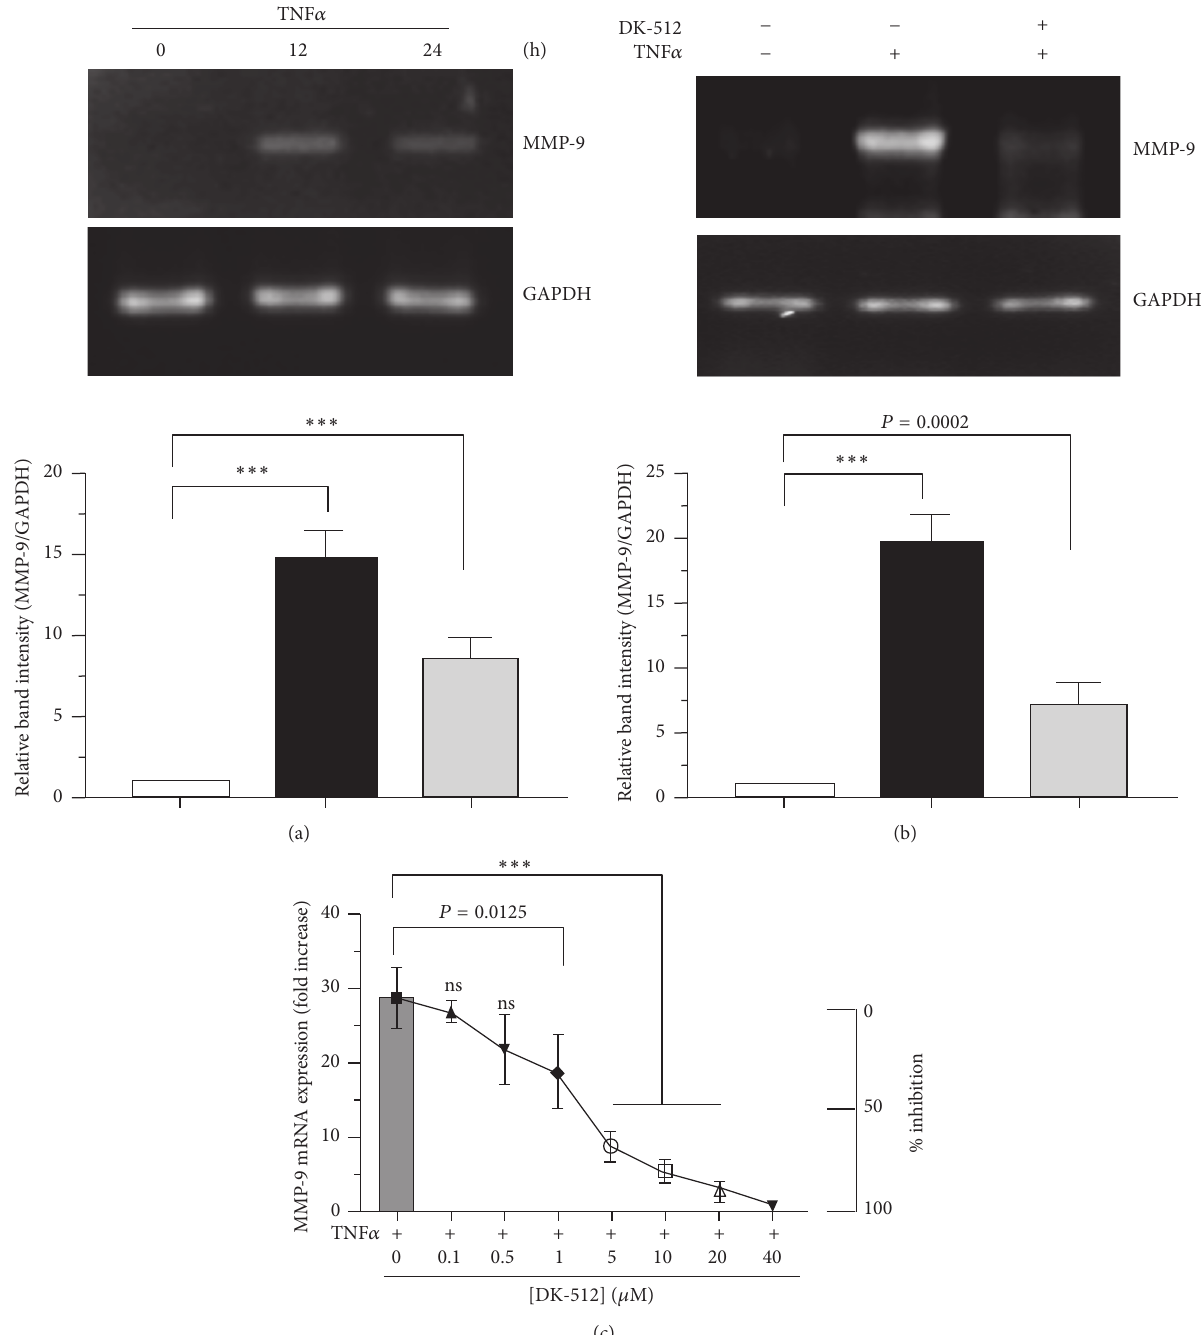
Figure 3: Effect of DK-512 on the inhibition of TNF 𝛼 -induced MMP-9 mRNA expression. (a) RT-PCR analysis. MDA-MB-231 cells were treated with 10ng/mL TNF 𝛼 for 12 and 18h. Total RNA was isolated and RT-PCR was performed. GAPDH mRNA was used as an internal control. Band intensities were measured using ImageJ software. The data shown represent the mean ± SD ( 𝑛 = 3 ). ∗∗∗ 𝑃 < 0.001 . P value was analyzed by Sidak’s test. (b) RT-PCR analysis. MDA-MB-231 cells were pretreated with 5 𝜇 M DK-512 for 30 min before the addition of 10ng/mL TNF 𝛼 . After 12h, total RNA was isolated and RT-PCR was performed. GAPDH mRNA was used as an internal control. Band intensities were measured using ImageJ software. The data shown represent the mean ± SD ( 𝑛 = 3 ). ∗∗∗ 𝑃 < 0.001 . 𝑃 value was analyzed by Sidak’s test. (c) Real-time PCR. MDA-MB-231 cells were pretreated with different concentrations of DK-512 before the addition of 10ng/mL TNF 𝛼 . After 12 h, total RNA was isolated and MMP-9 mRNA levels were measured by quantitative real-time PCR. The relative fold changes were normalized to GAPDH mRNA in the same sample. The data shown represent the mean ± SD ( 𝑛 = 3 ). ns: not significant compared to TNF 𝛼 -only treatment. ∗∗∗ 𝑃 < 0.001 . P value was analyzed by Sidak’s